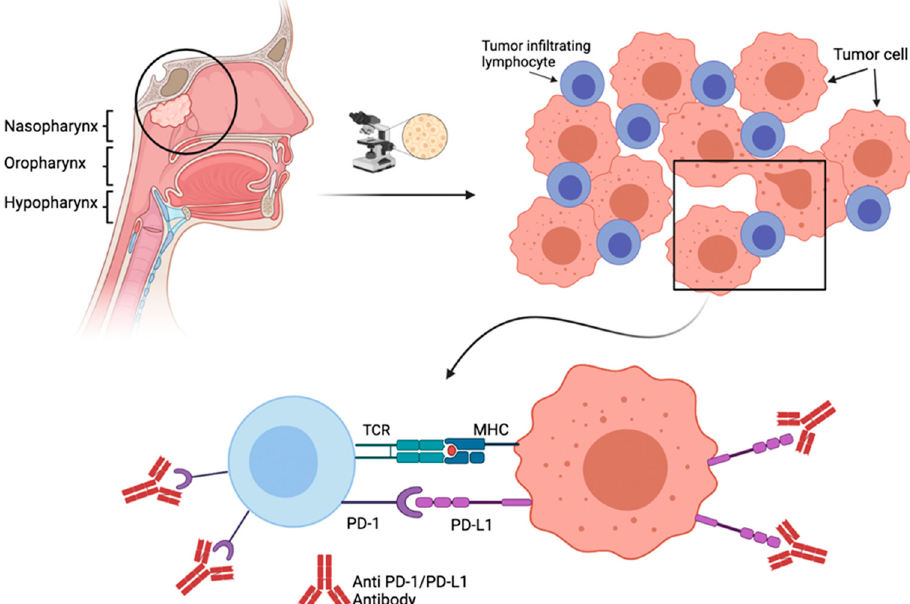
Figure 1. Tumor microenvironment of immune-rich nasopharyngeal carcinoma (NPC). NPC is often associated with heavy lymphocyte infiltration in a histologic setting. Tumor cells express high levels of PD-L1 as a way to evade the adaptive immune system, which have since served as targets for immunomodulation therapies.